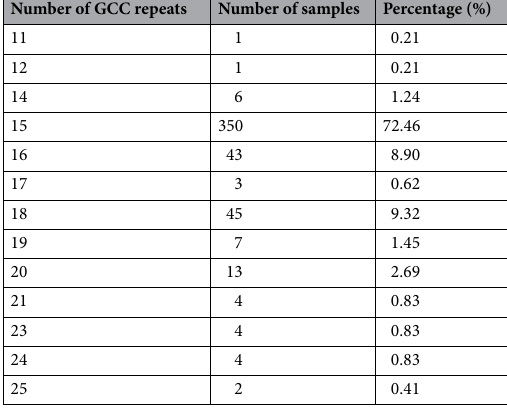
Table 1. Homozygous genotypes identified among the 500 female